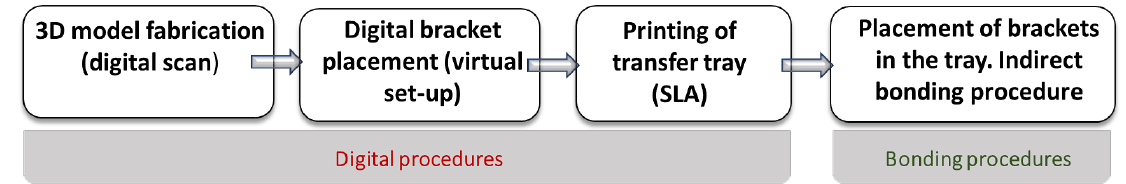
Figure 4. The virtual orthodontic technique.